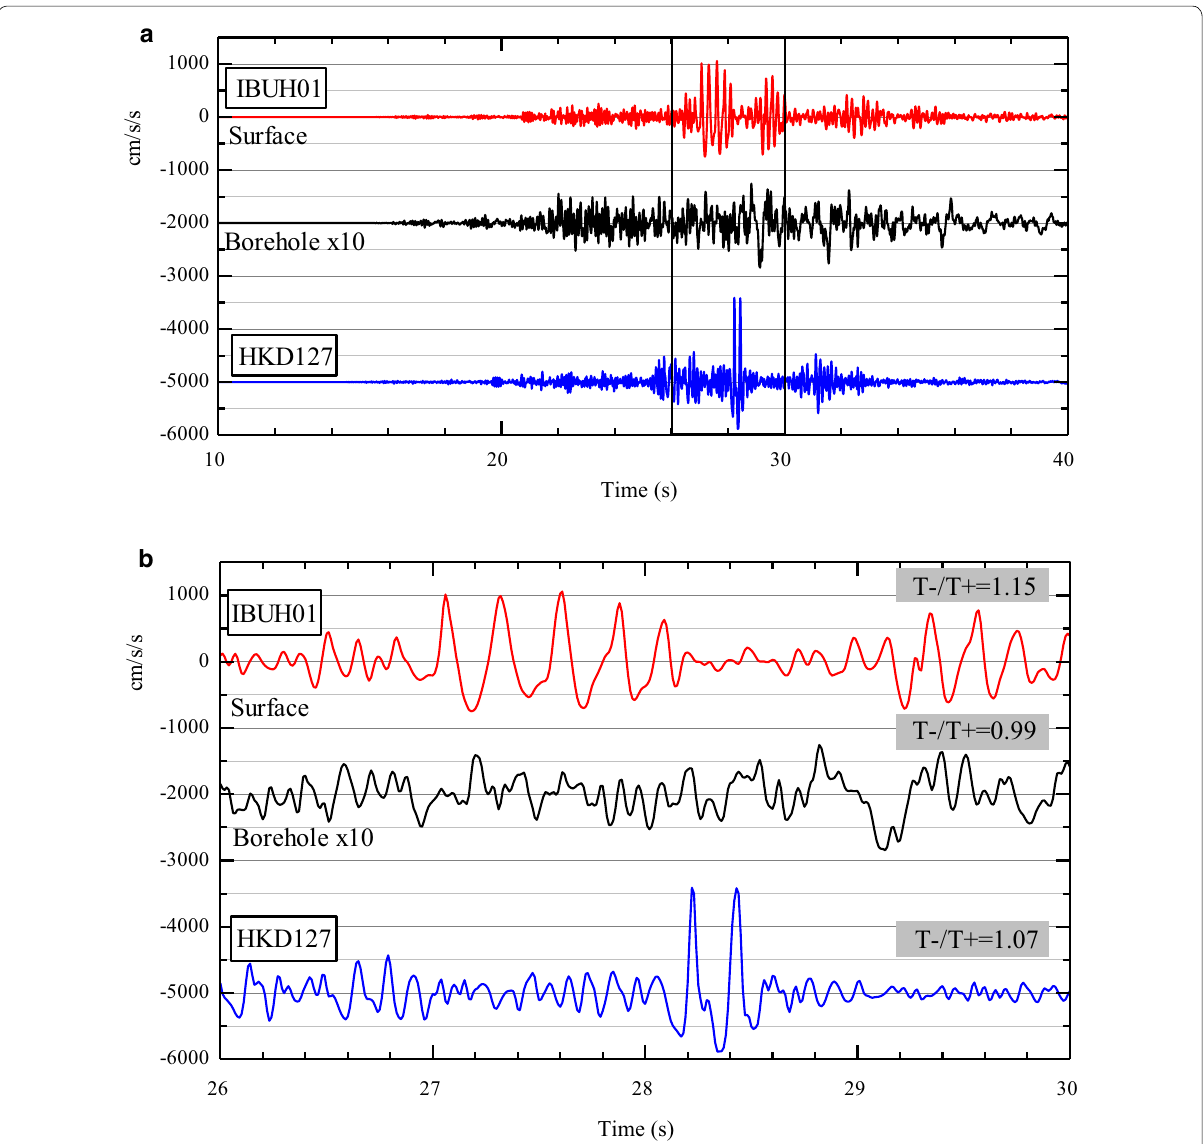
Fig. 9 a Vertical component acceleration recordings at the surface (upper panel) and borehole (middle panel) at site IBUH01 and the surface at HKD127 (lower panel). The values for the borehole recordings are magnified by a factor of 10 to aid visual comparison. A black rectangle denotes the portion of the plot, which is enlarged in b . The ratio of total duration of negative pulses to the total duration of positive pulses is indicated above each trace for the time window from 26 to 30 s in b . See Fig. 3 for site location and text for further